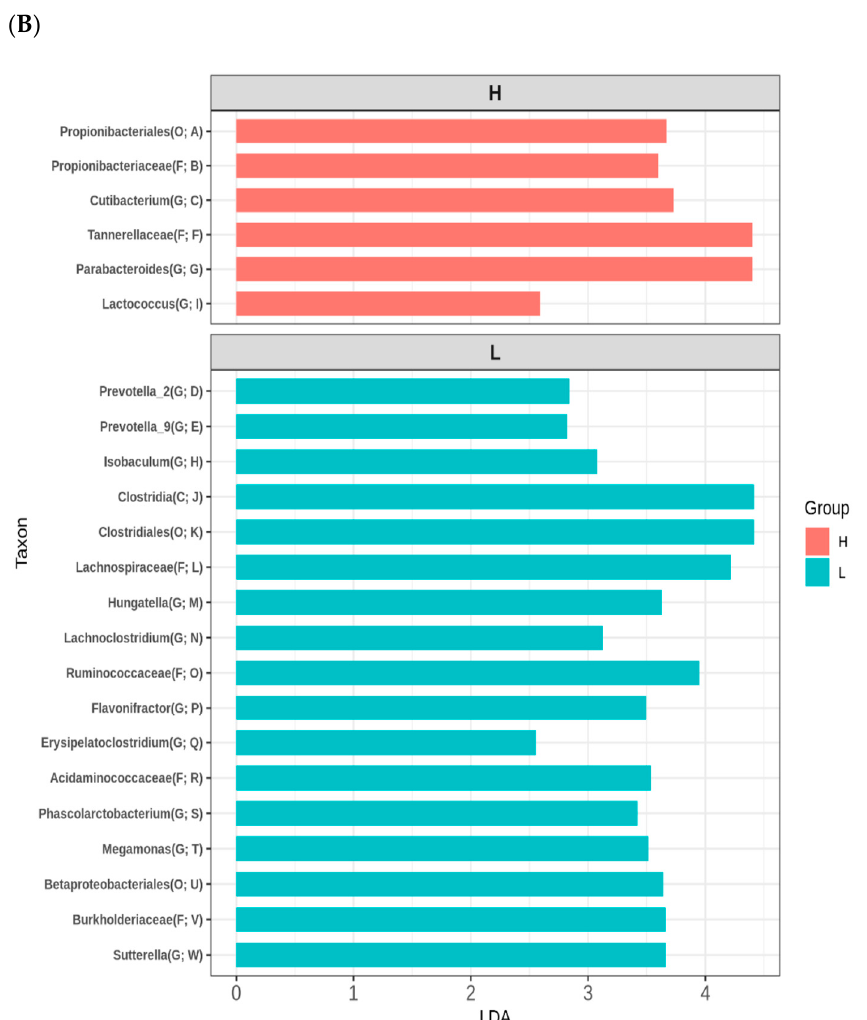
Figure 2. Variations in the infant gut microbiome at 2 months of age according to maternal fruit and vegetable consumption during pregnancy. ( A ) Principal coordinates analysis (PCoA) on unweighted unique fraction (UniFrac). ( B ) linear discriminant analysis effect size (LEfSe). The ordination is from A to W in a tree diagram (Figure S3). Definition of abbreviation: H, high maternal consumption of fruits and vegetables during pregnancy; L, low maternal consumption of fruits and vegetables during pregnancy; O, order; F, family; G, genus.